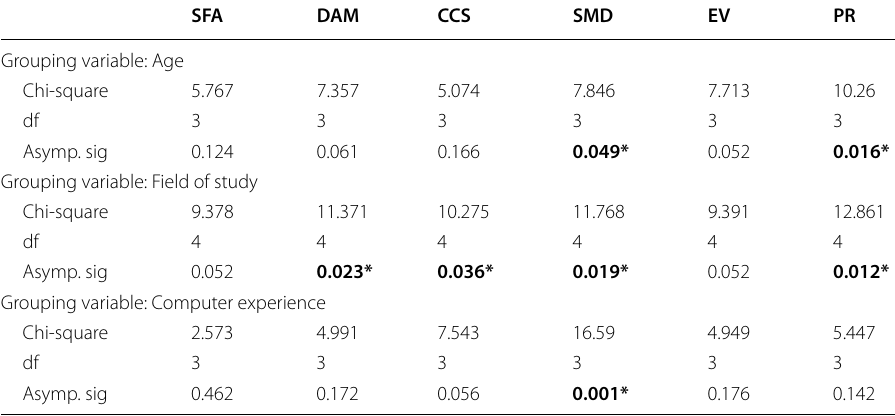
Table 6 Kruskal Wallis tests on student groups across the six components of SDiCoS students’ digital competence